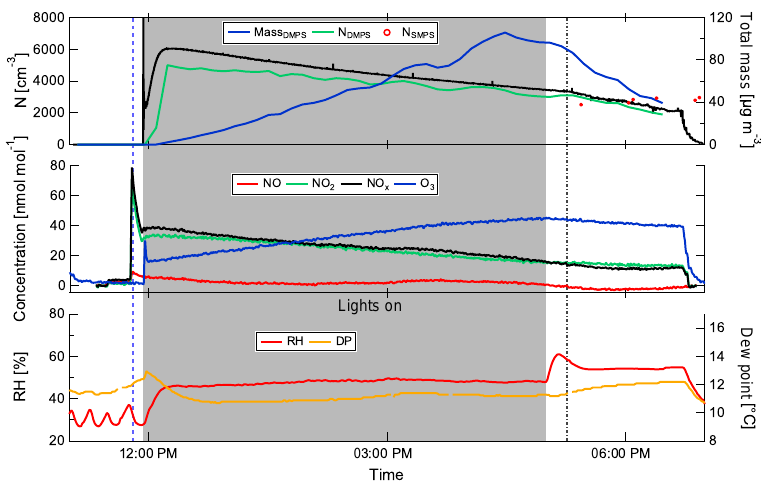
Figure 3. Development of SOA particles in the aerosol chamber. The blue dashed line indicates the injection of the SOA precursors, the grey dash-dotted line the beginning of the transfer to the cloud chamber. The grey shading indicates the time with the lights switched on. This example shows the development of SOA from the heptadecane precursor (experiment 8; see Table 1). Table 3. Conditions in the aerosol chamber shortly before transfer to the cloud chamber and aerosol properties after transfer in MICC. Experiment Precursor Time with lights on